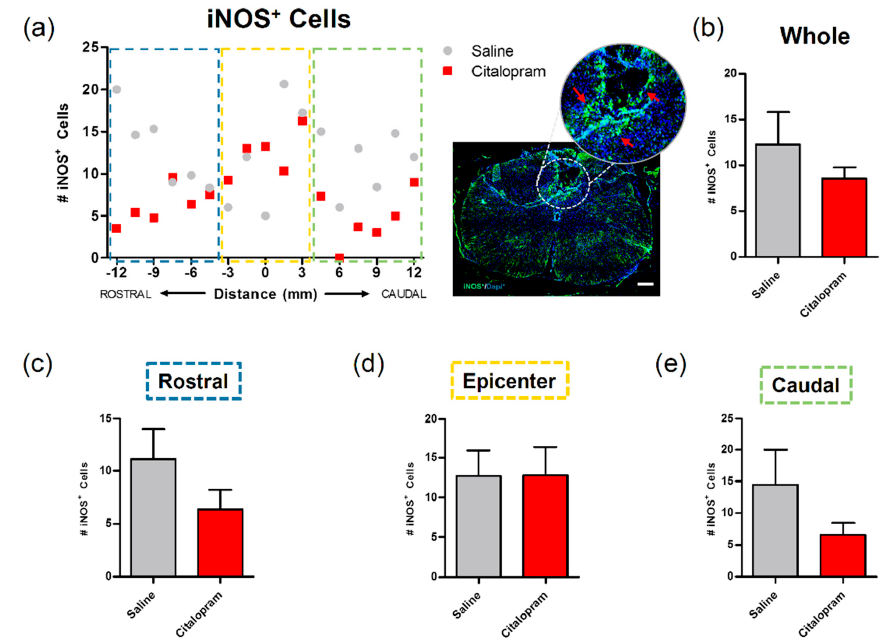
Figure 3. Impact of 7-day citalopram treatment on iNOS-expressing cells. ( a ) Distribution of the number of iNOS+ cells along the rostro–caudal axis of the spinal cord; ( b ) quantification of the number of iNOS+ cells in the total analyzed area. Analysis of the spinal cord was then subdivided into ( c ) rostral, ( d ) lesion epicenter and ( e ) caudal areas of citalopram- ( n = 5) vs. vehicle-treated animals ( n = 6). Values shown as mean ± SEM. Scale bar: 200 μ m.